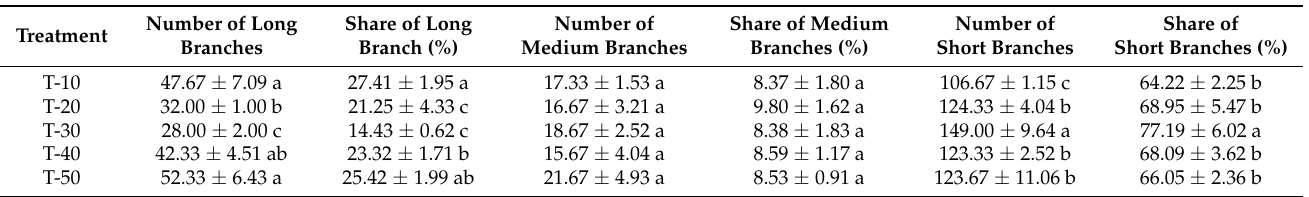
Table 3. Effects of different dwarfing interstock lengths on the number and share of different types of branches (2020).